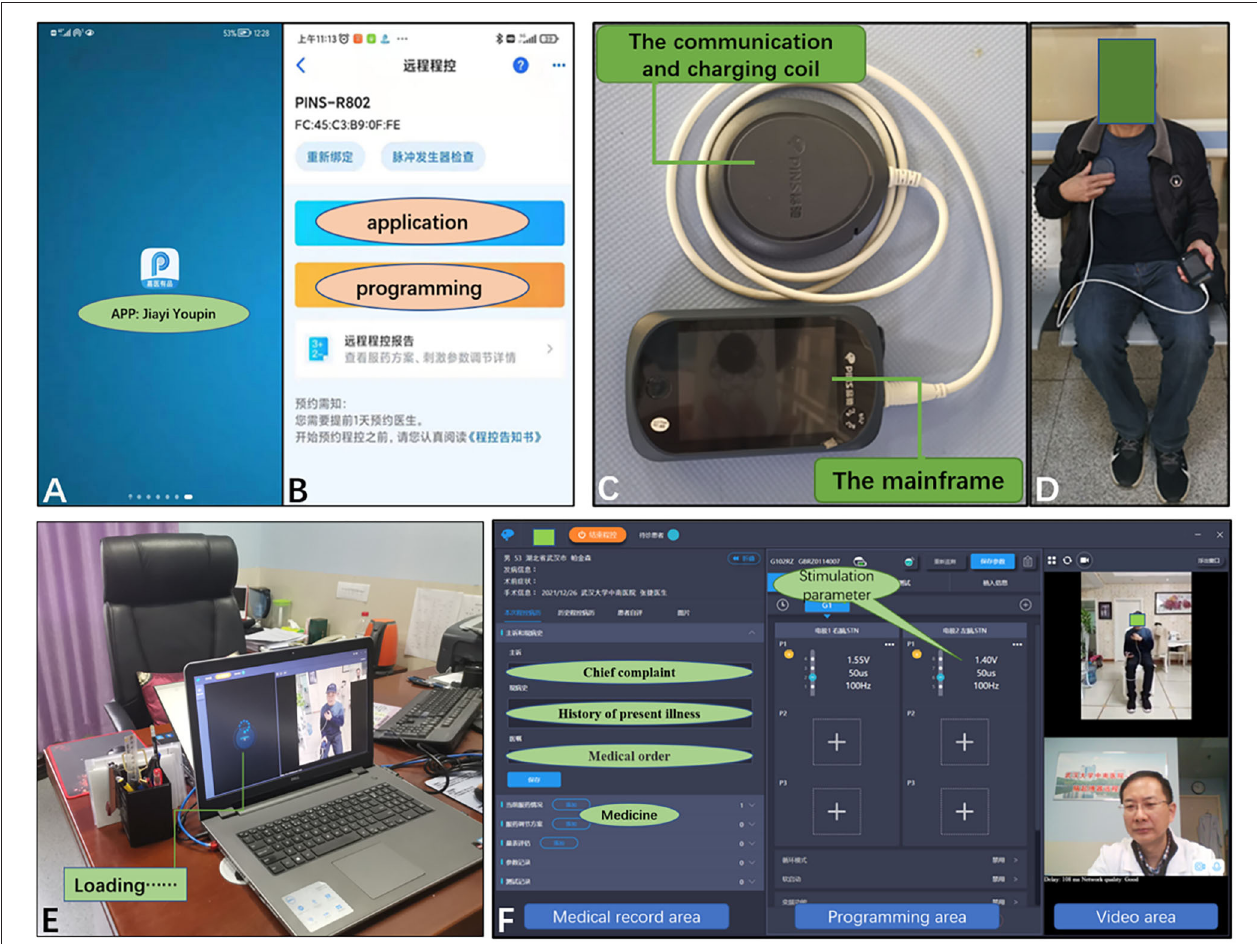
FIGURE 2 | (A) Patients needed to download the programming app, PINS “JiayiYoupin” patient version. (B) Patients applied for programming using the app. (C) The patient programmer consisted of a communication/charging coil and a mainframe, which can be used for programming and charging the IPG. (D) Working status of the patient programmer. (E) Doctor was detecting IPG signals in patient. (F) Computer interface of the physician client during remote programming, as well as the display of its functions. IPG, implantable pulse